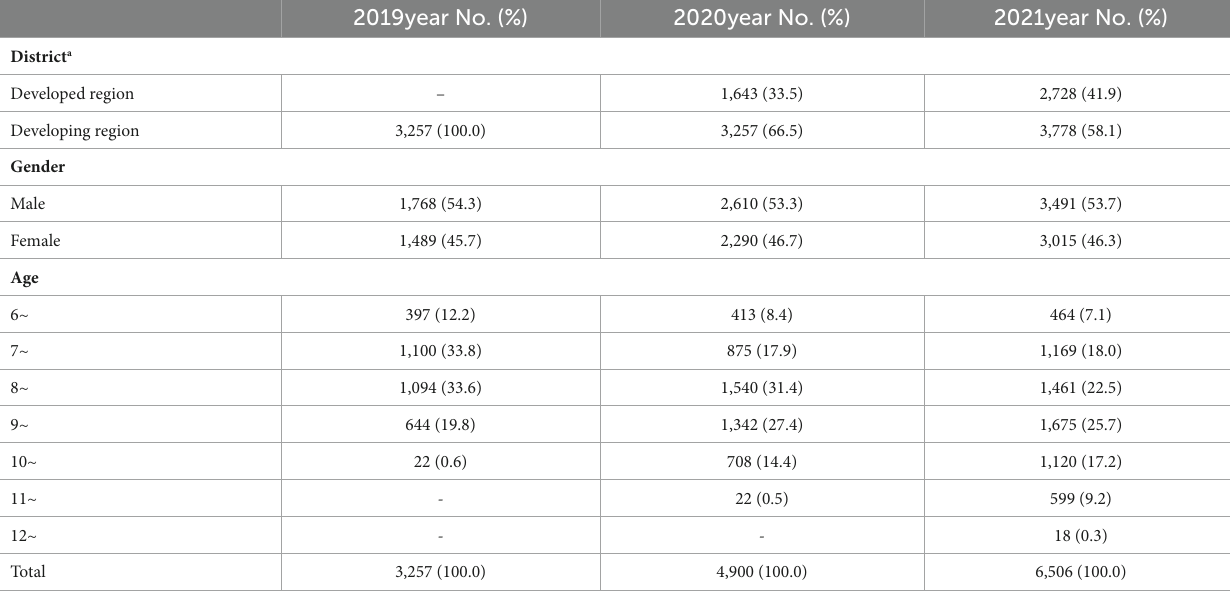
TABLE 1 Cohort profiles of students in the Eastern China Student Health and Wellbeing Cohort Study. 2019 year No. (%) 2020 year No. (%) 2021 year No. (%)